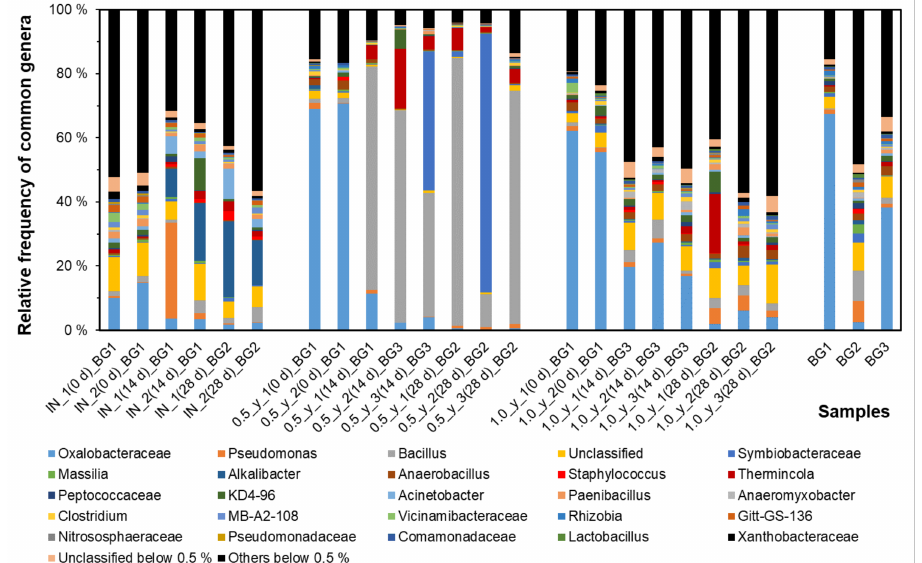
Figure 7. Relative abundance of detected microbial genera by NGS sequencing. The sample notation reflects the number from replicates, the cultivation time, and background (BG) controls co-extracted with each